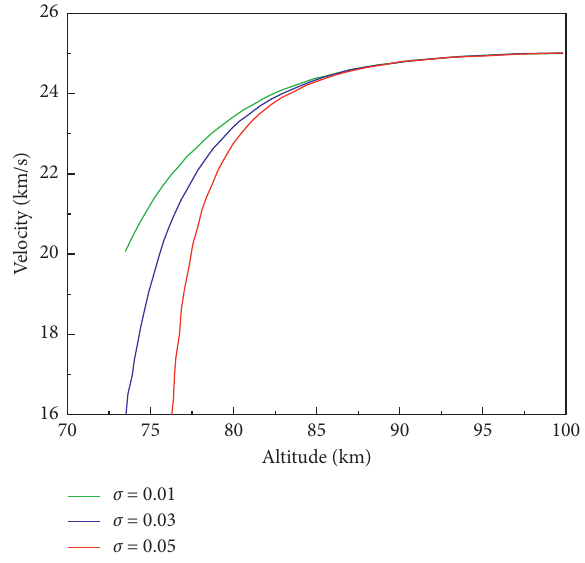
Figure 4: Comparison of meteoroids having the same initial � 25km/s) but different ablation conditions ( m 0 � 1 g, v 0 coefficients. Table 1: Comparison of the ablation coefficients for various meteor cases from the JVB